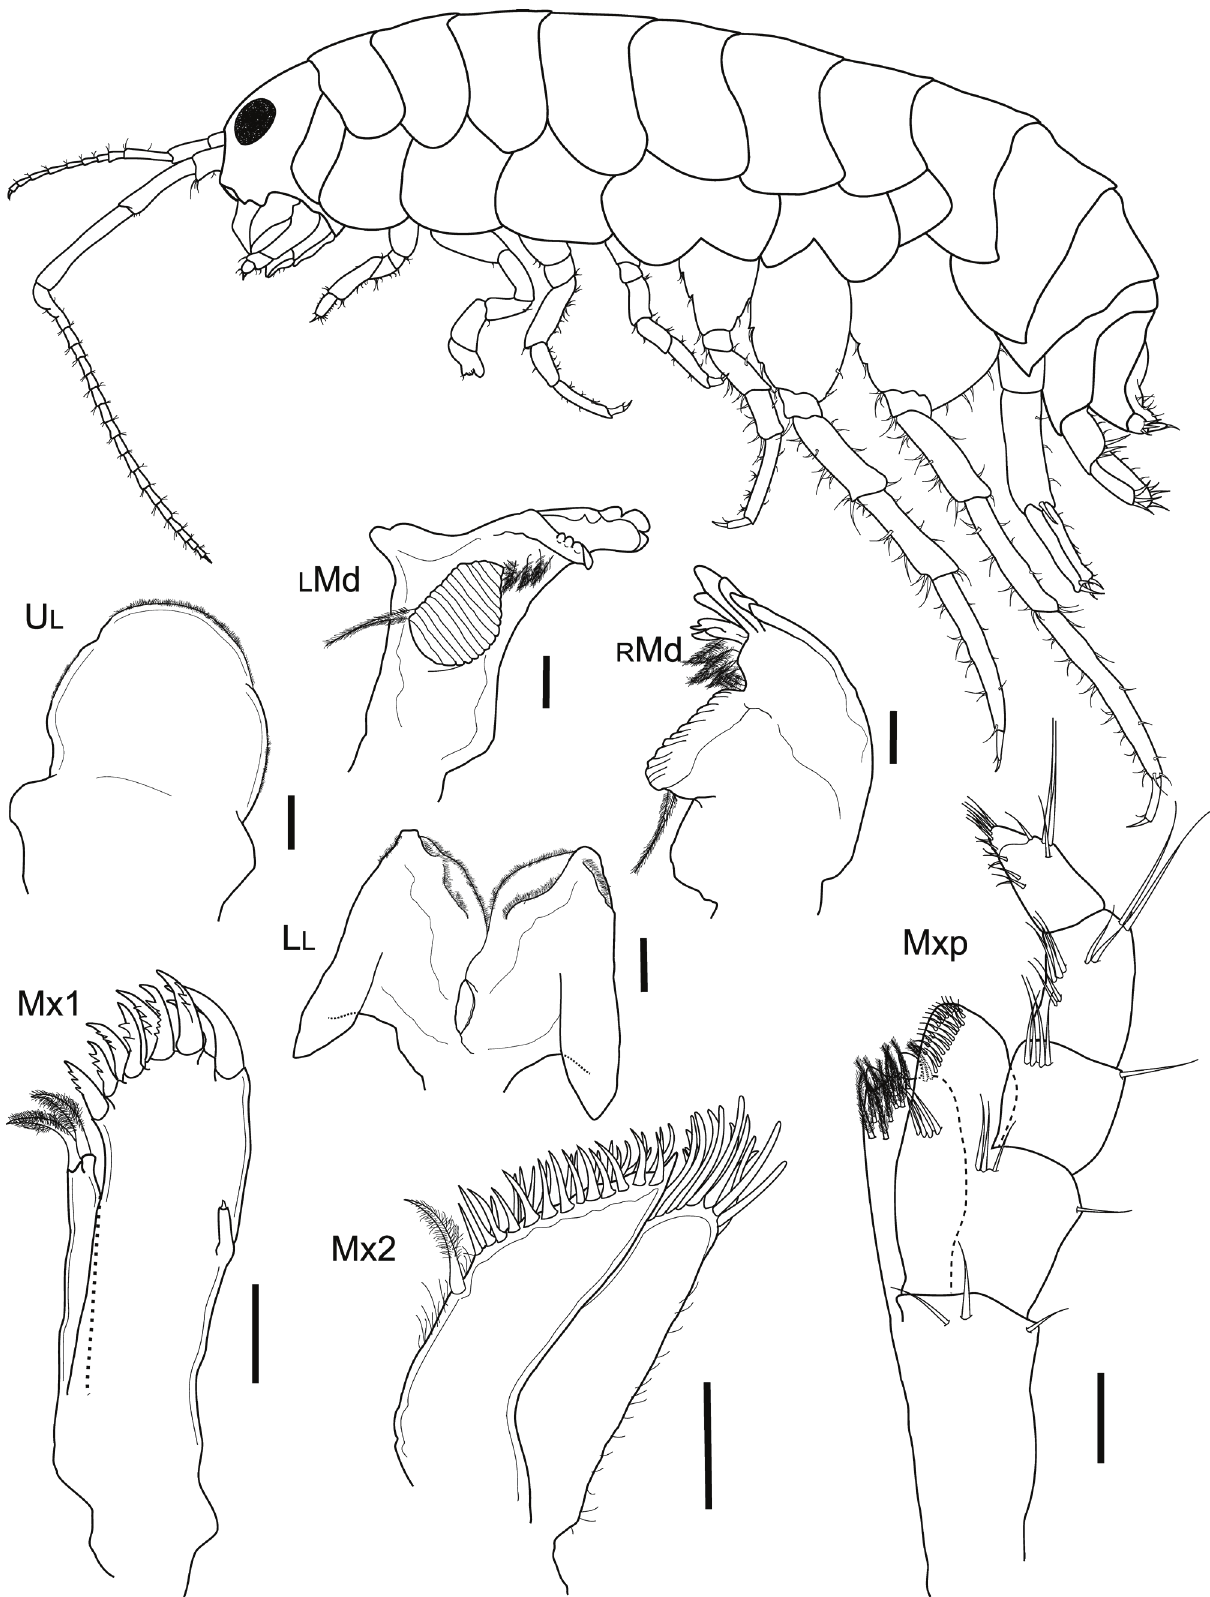
Figure 4. Talitroides topitotum (Burt, 1934). Female, 11.9 mm, MNRJ 14470: Habitus; Female, 12.2 mm, MNRJ 14470: Mouthparts. Scales = 0.1